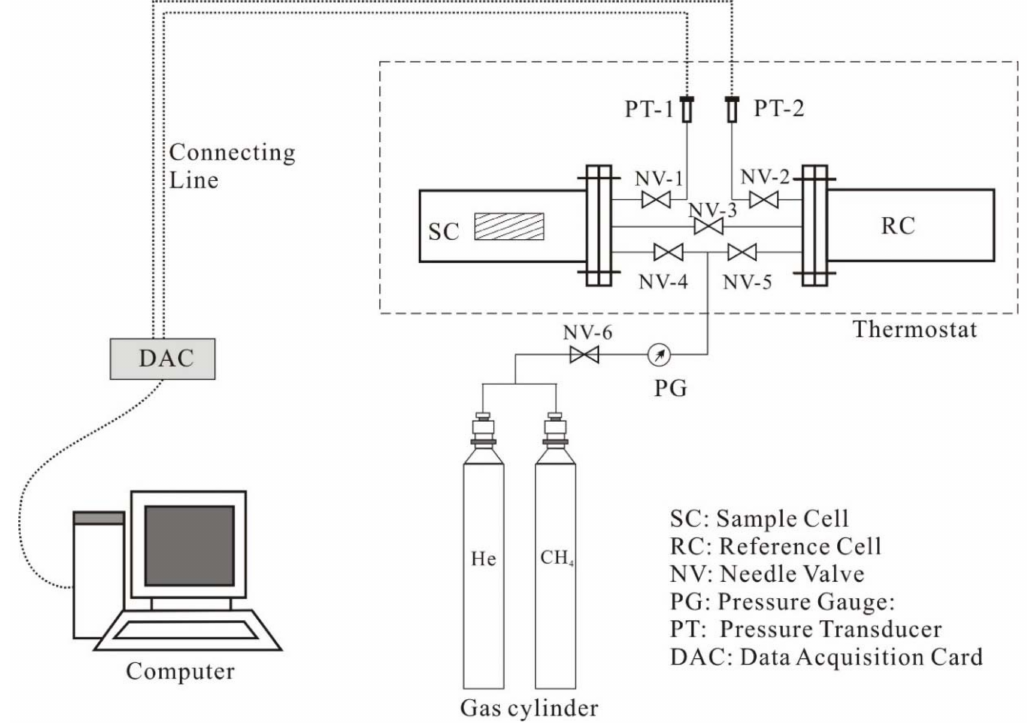
Figure 1. Experimental devices for CH 4 adsorption and